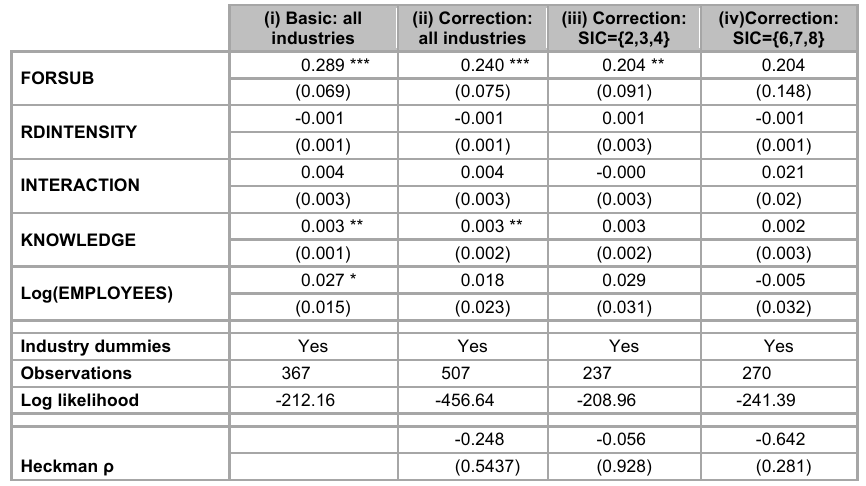
Regression results for multinational corporations and the introduction of foreign innovations by all industries, non-services industries and services